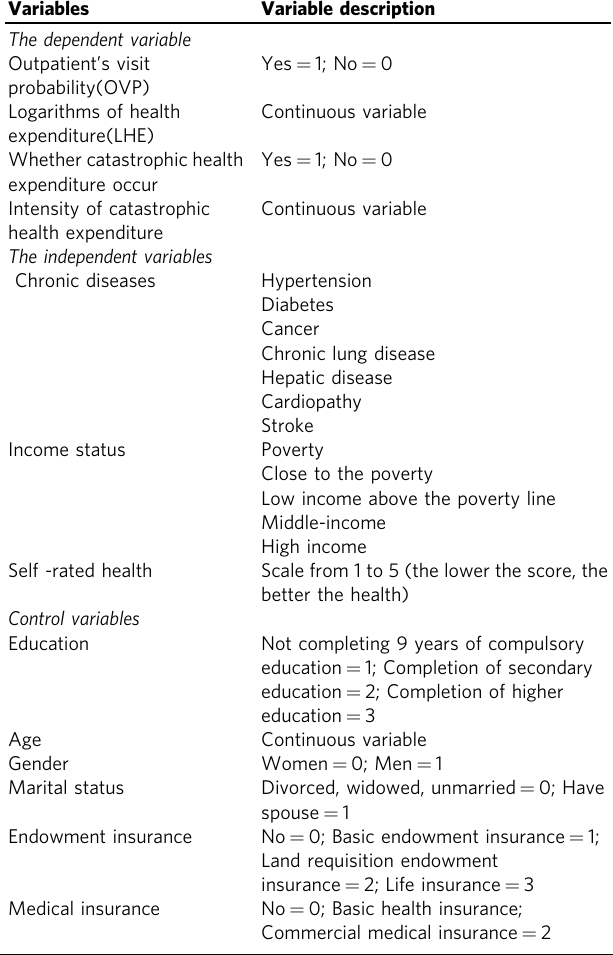
Table 1 Variable de fi